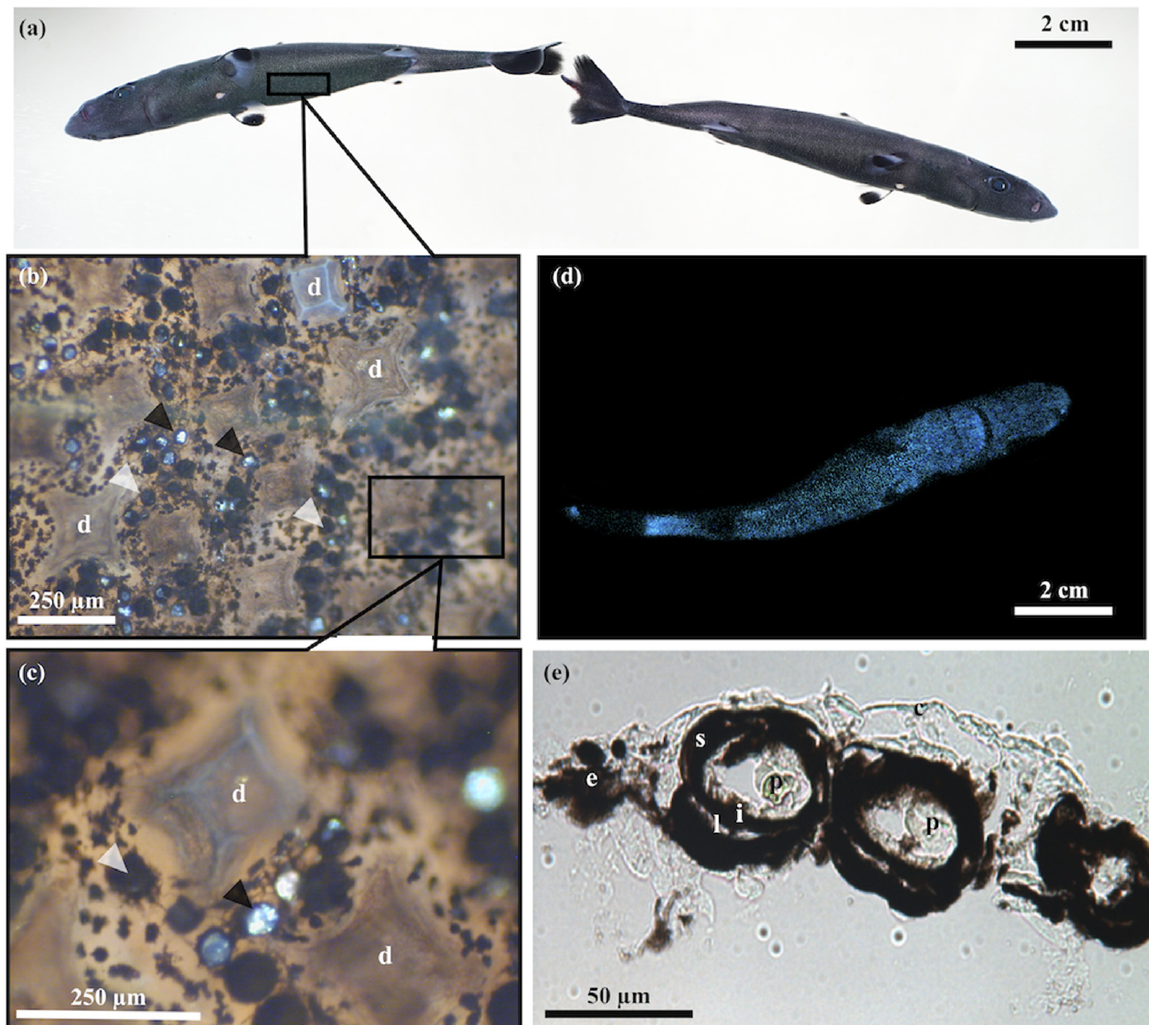
Figure 1. General aspects of Squaliolus aliae luminescent structures. ( a ) Ventral (left) and lateral (right) pictures of adults S. aliae . ( b ) Placoid scales and photophore observation on a ventral skin patch. ( c ) Closer view of typical pavement-shaped placoid scales surrounded by open and closed photophores. ( d ) Picture of the ventral side luminescent pattern of in utero S. aliae embryo. ( e ) Cross section of the photogenic skin of adult S. aliae showing classical photophore histology. Dark arrow- head: closed photophore; white arrowhead: open photophores. d: dermal scales; e: epidermis; i: iris- like structure; l: lens cell; p: photocyte; s: pigmented sheath.